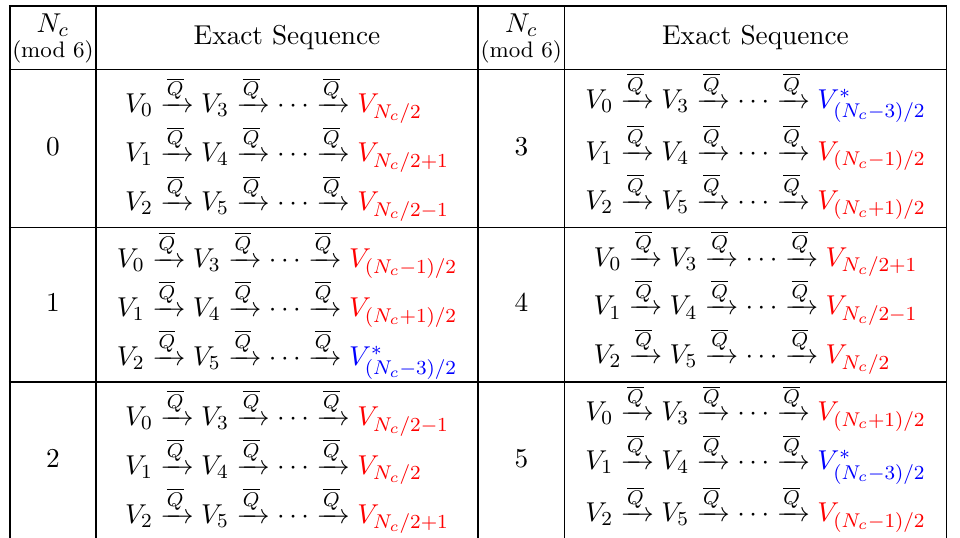
Table 8 . Exact sequences of the Hilbert spaces generated by the linear map Q . Complementary exact sequences descending from V N , V N , and V N by way of Q can be obtained by applying c c (cid:0) 1 c (cid:0) 2 the particle-hole operator P to the sequences in the table. The spaces V contain an exponentially large number of \typical" zero modes, see (6.5). The spaces V (cid:3) contain no zero modes for N c = 3